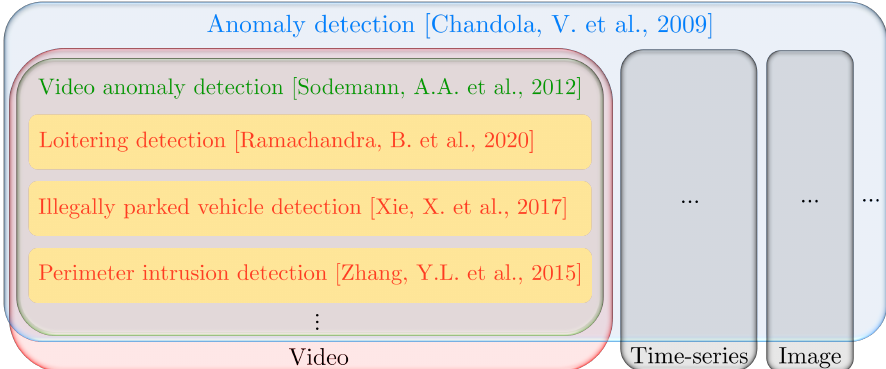
Figure 1. Venn diagram to illustrate the taxonomy of tasks in video anomaly